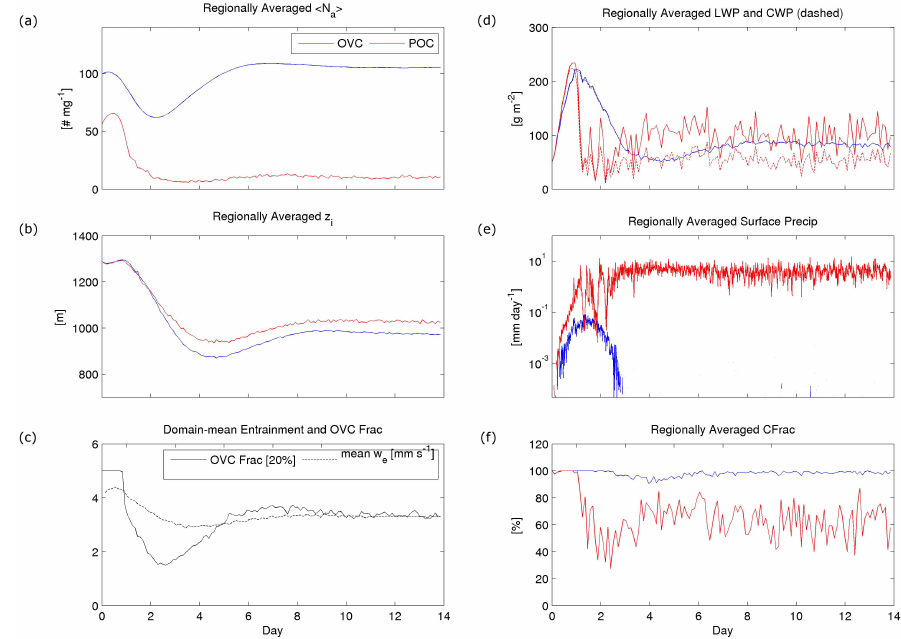
Fig. 15. Time series averaged from 24km wide strips centered within the overcast (OVC) and POC. Left column shows panels (a) aerosol number concentration h N a i , (b) inversion height z i , and (c) overcast fraction and domain-mean entrainment w e ; right column shows panels (d) LWP (solid) and CWP (dashed), (e) surface precipitation, and (f) cloud fraction.